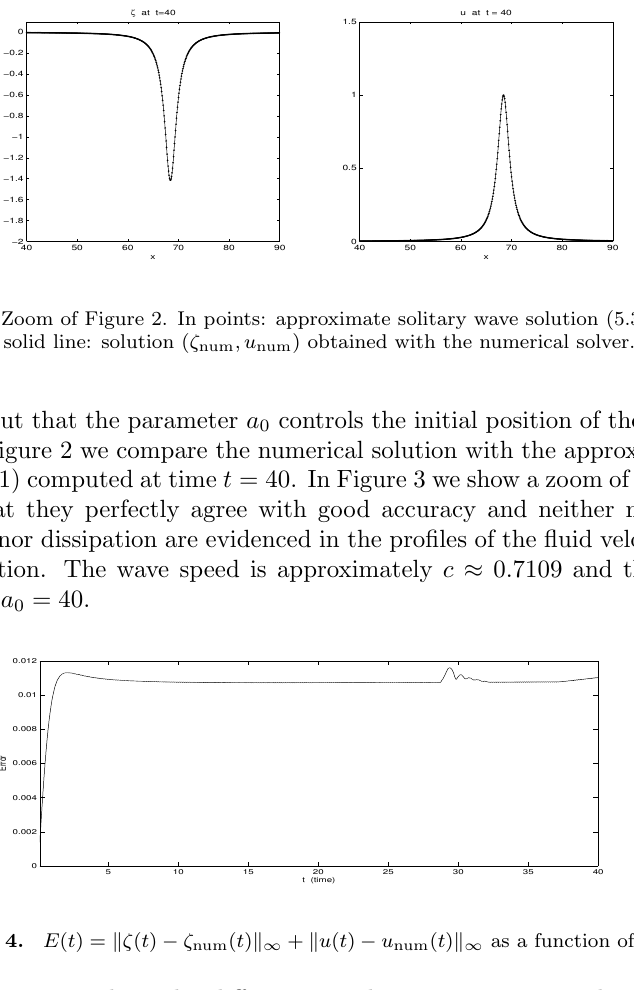
Figure 4. E ( t ) = (cid:107) ζ ( t ) − ζ num ( t ) (cid:107) ∞ + (cid:107) u ( t ) − u num ( t ) (cid:107) ∞ as a function of time. In Figure 4 we show the difference in the supremum norm between the numerical solution and the approximate solitary wave solution given in